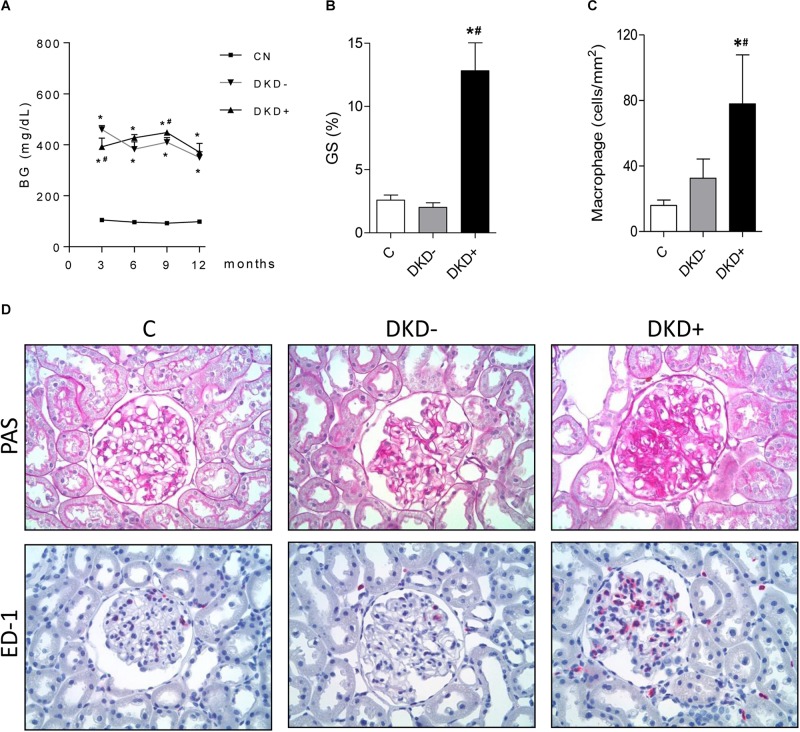
Twelve months after STZ injection, the 10 DM rats with the highest values for percent glomerulosclerosis (%GS) were used to create the DKD+ group, whereas the 10 DM rats with the lowest %GS values constituted the DKD– group. Twelve non-diabetic age-matched rats were taken as controls (C). The time course of blood glucose concentration (BG, mg/dL) is shown in panel (A), whereas the %GS and glomerular macrophage density (ED-1, cells/mm2) at 12 months of DM appear at panels (B,C), respectively. Representative microphotographs of renal tissue stained with PAS (for %GS) or immunohistochemistry (for macrophage-specific ED-1 antigen) are shown in panel (D) (x400). Results expressed as means ± SE. * p < 0.05 vs. C, #p < 0.05 vs. DKD–.